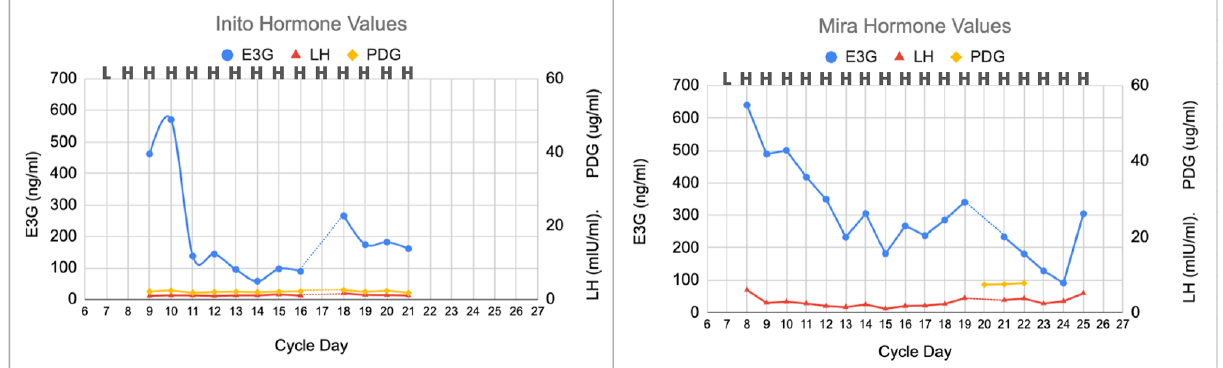
Figure 3. Anovulatory cycle showing no LH surge and no PDG rise. E3G fluctuations were present at the beginning and middle of the cycle, but no luteinization, progestation, or luteolysis processes were observed.